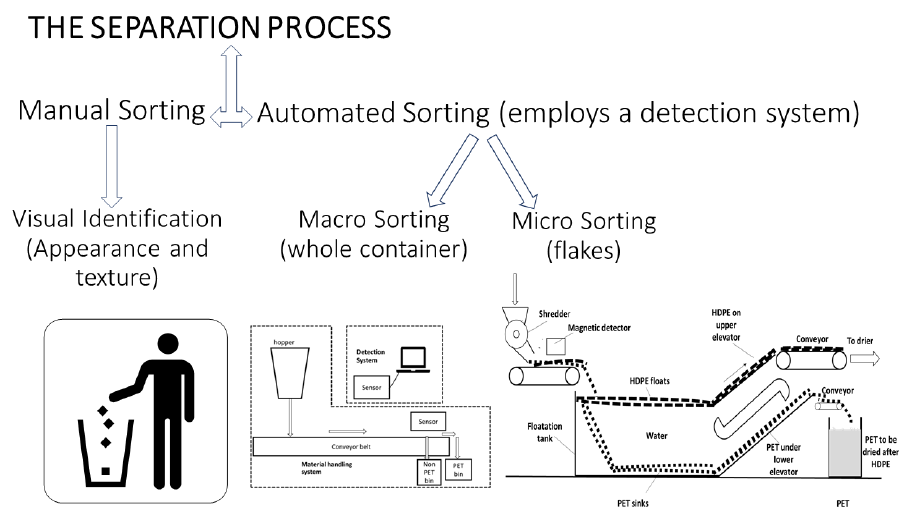
Figure 2. Plastic resin separation/sorting process. Adapted from [74,76]. PET—polyethylene tereph- thalate, HDPE—high-density polyethylene.